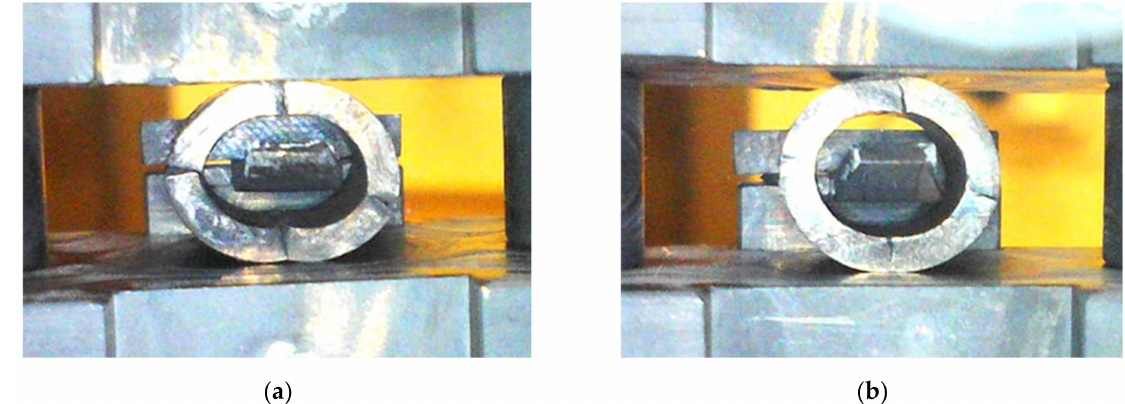
Figure 26. ( a ) 100 dpa specimen and ( b ) 65 dpa specimen after test in PWR water with 21 cc/kg H 2 .